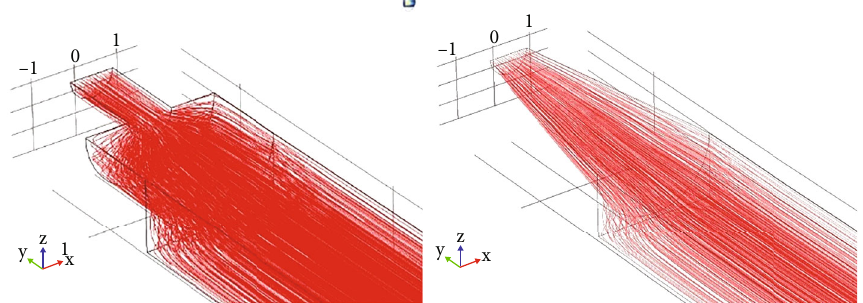
Figure 3: Gas circuit simulation